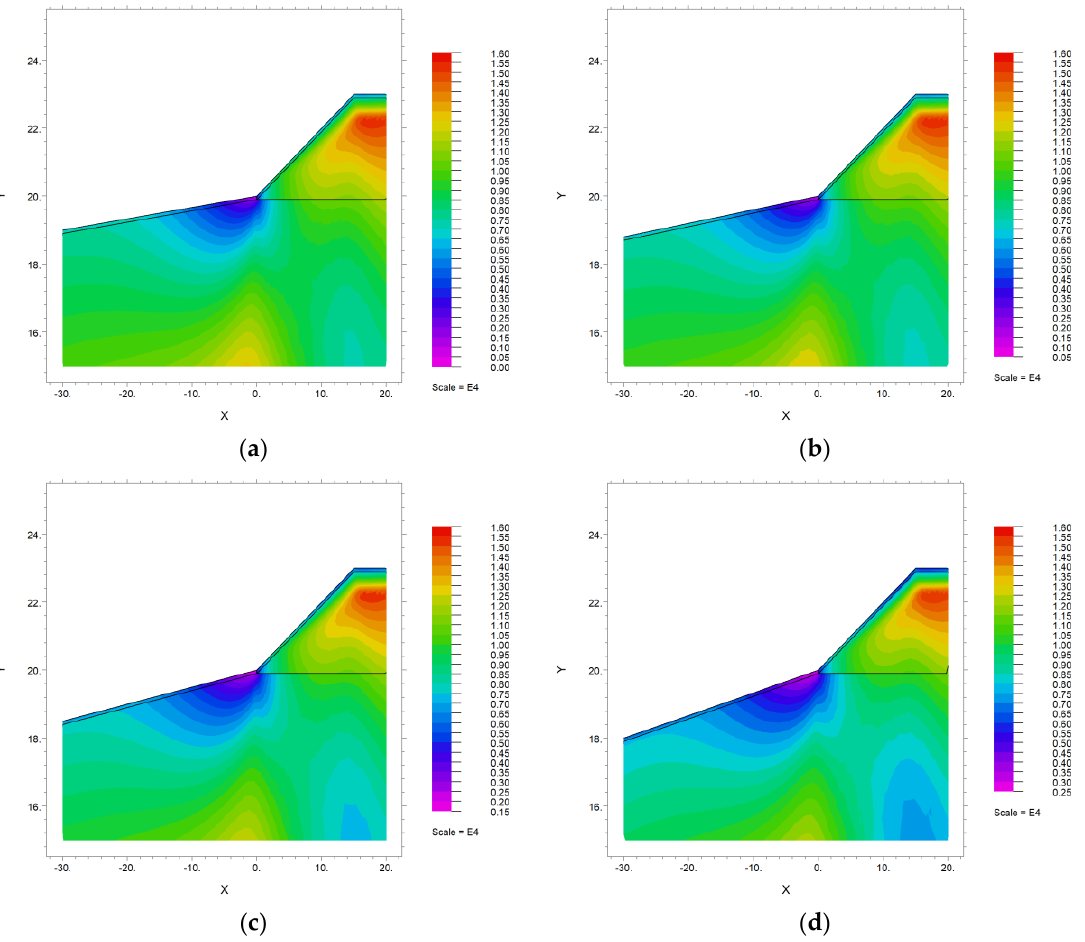
Figure 6. Coulomb – Mohr potential for the sand-type subsoil, for underwater slope inclinations of: ( a ) 1:30, ( b ) 1:25, ( c ) 1:20, ( d ) 1:15 (negative values indicate compressive stresses in Pa, and positive values — tensile stresses in Pa).